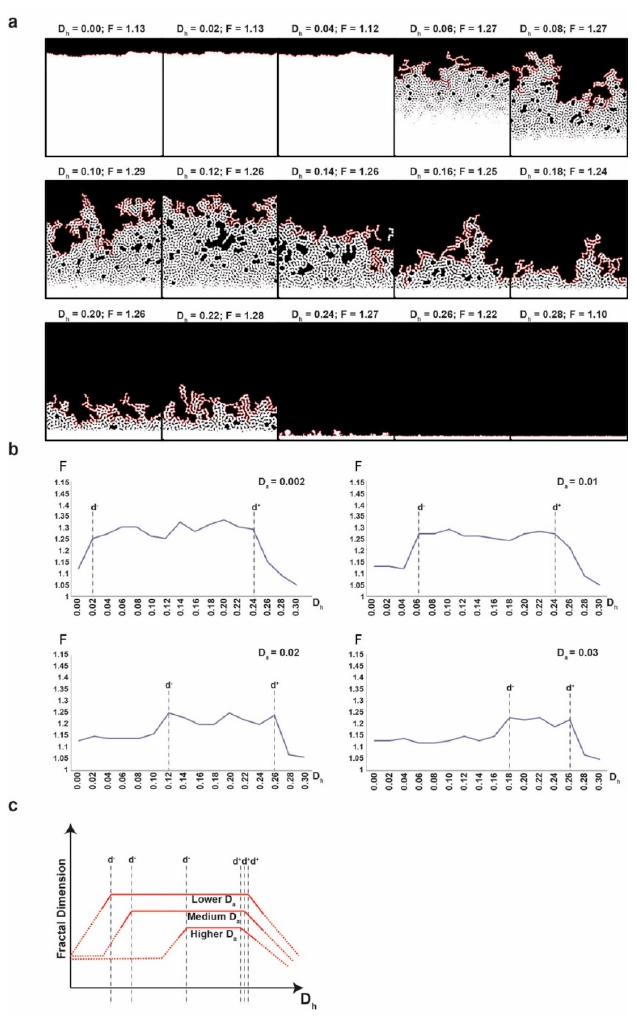
Figure 3. (a) Final configuration for D h = 0.00, 0.02, 0.04, …, 0.28 and D a = 0.01 in the left to right reading order. For each D h value, the corresponding fractal dimension (F) is presented. White colour depicts cells, black depicts empty space. (b) The fractal dimension (F) of the final configurations for D h = 0.00, 0.02, 0.04, …, 0.30 for four different values of D a (0.002, 0.01, 0.02 and 0.003). (c) The graphical representation of the dependence of the fractal dimension of D a and D h , illustrating the general phenomenon observed. With doted lines, we represent the lower values outside the intermediate interval for which we ignore the small variations, irrelevant for our conclusion.